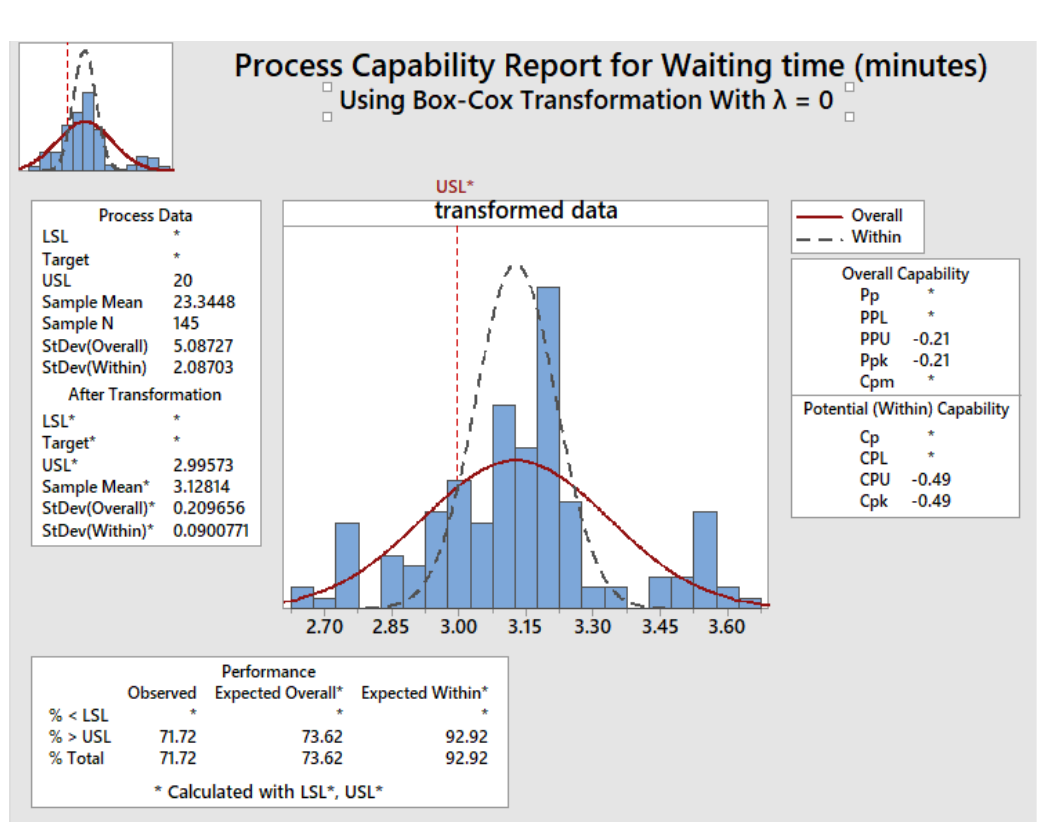
Figure 5. Process capability analysis of transformed waiting time